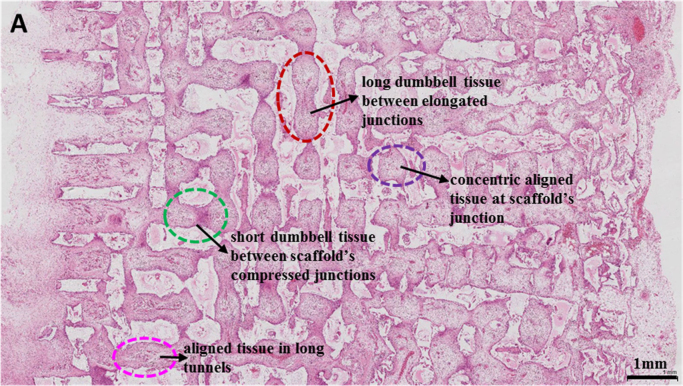
Hematoxylin & Eosin (H&E) stained histological structure of middle in-plane of 50CC scaffold explants at week 12 depicting tissue ingrowth within the scaffold network, ×2 magnifications.